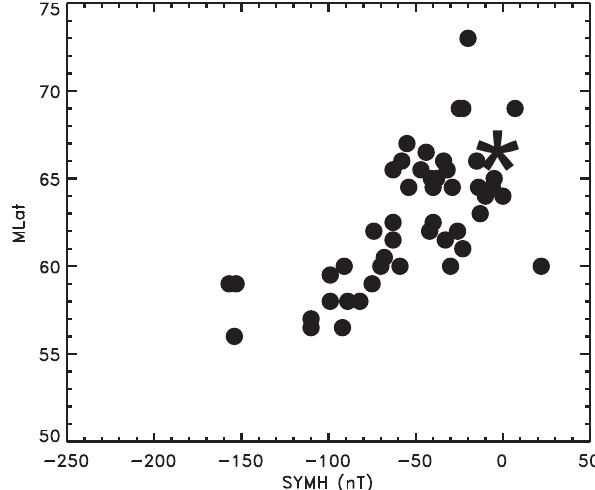
Fig. 5a. ILat locations of localized onsets as a function of normal- ized storm time. Asterisk indicates the average onset location for isolated substorms.